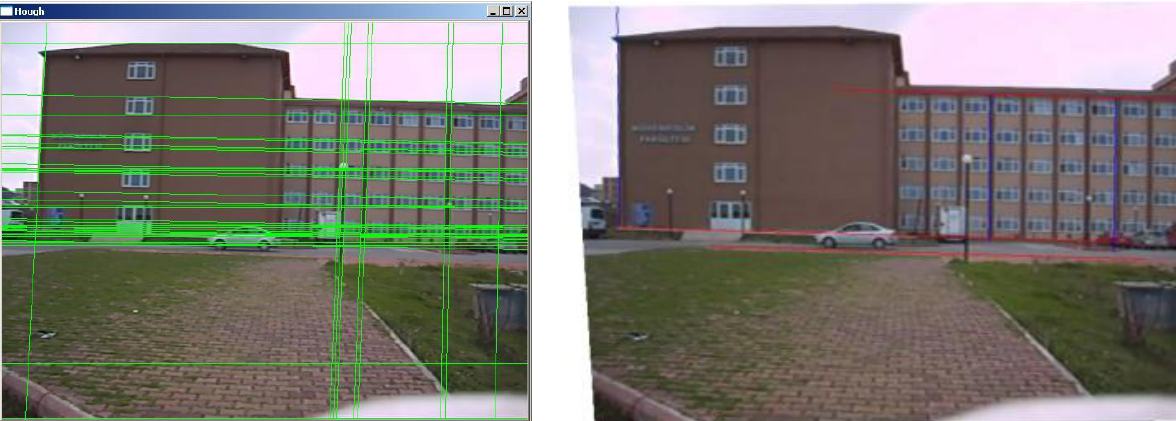
Figure 5. Vanishing lines found with Hough transformation (left) and rectified image